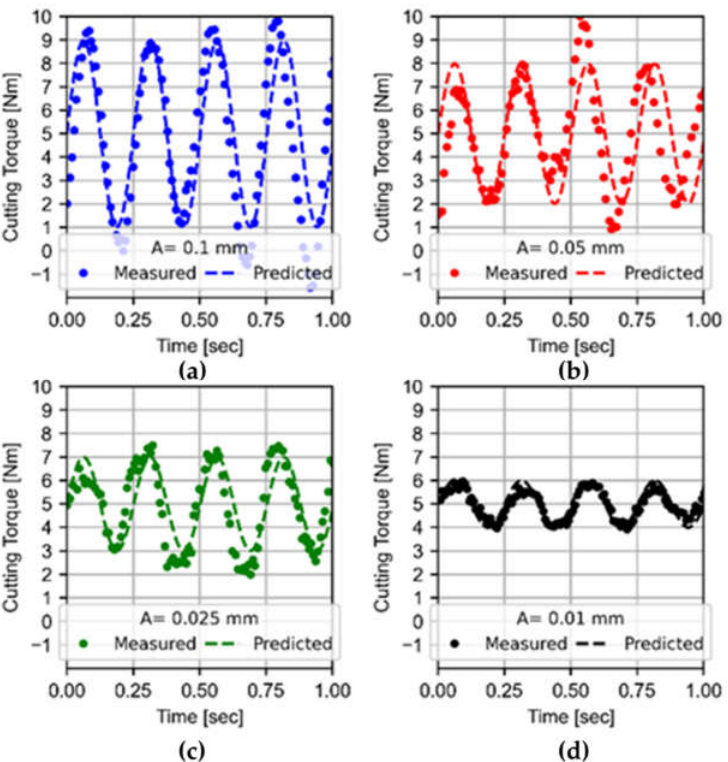
Figure 11. Measured and predicted torques of LFAB processes with vibrational conditions: ( a ) A = 0.1 mm, ( b ) A = 0.05 mm, ( c ) A = 0.025 mm and ( d ) A = 0.01 mm with constant Vc = 250 m/min, f z = 0.05 mm/tooth, DOC = 0.5 mm and f = 4 Hz; tests 19–22 in Table 2.